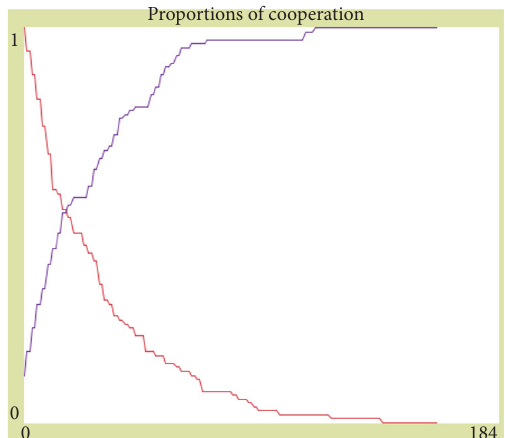
Figure 3: Influence of increasing knowledge workers’ salaries on CWB.